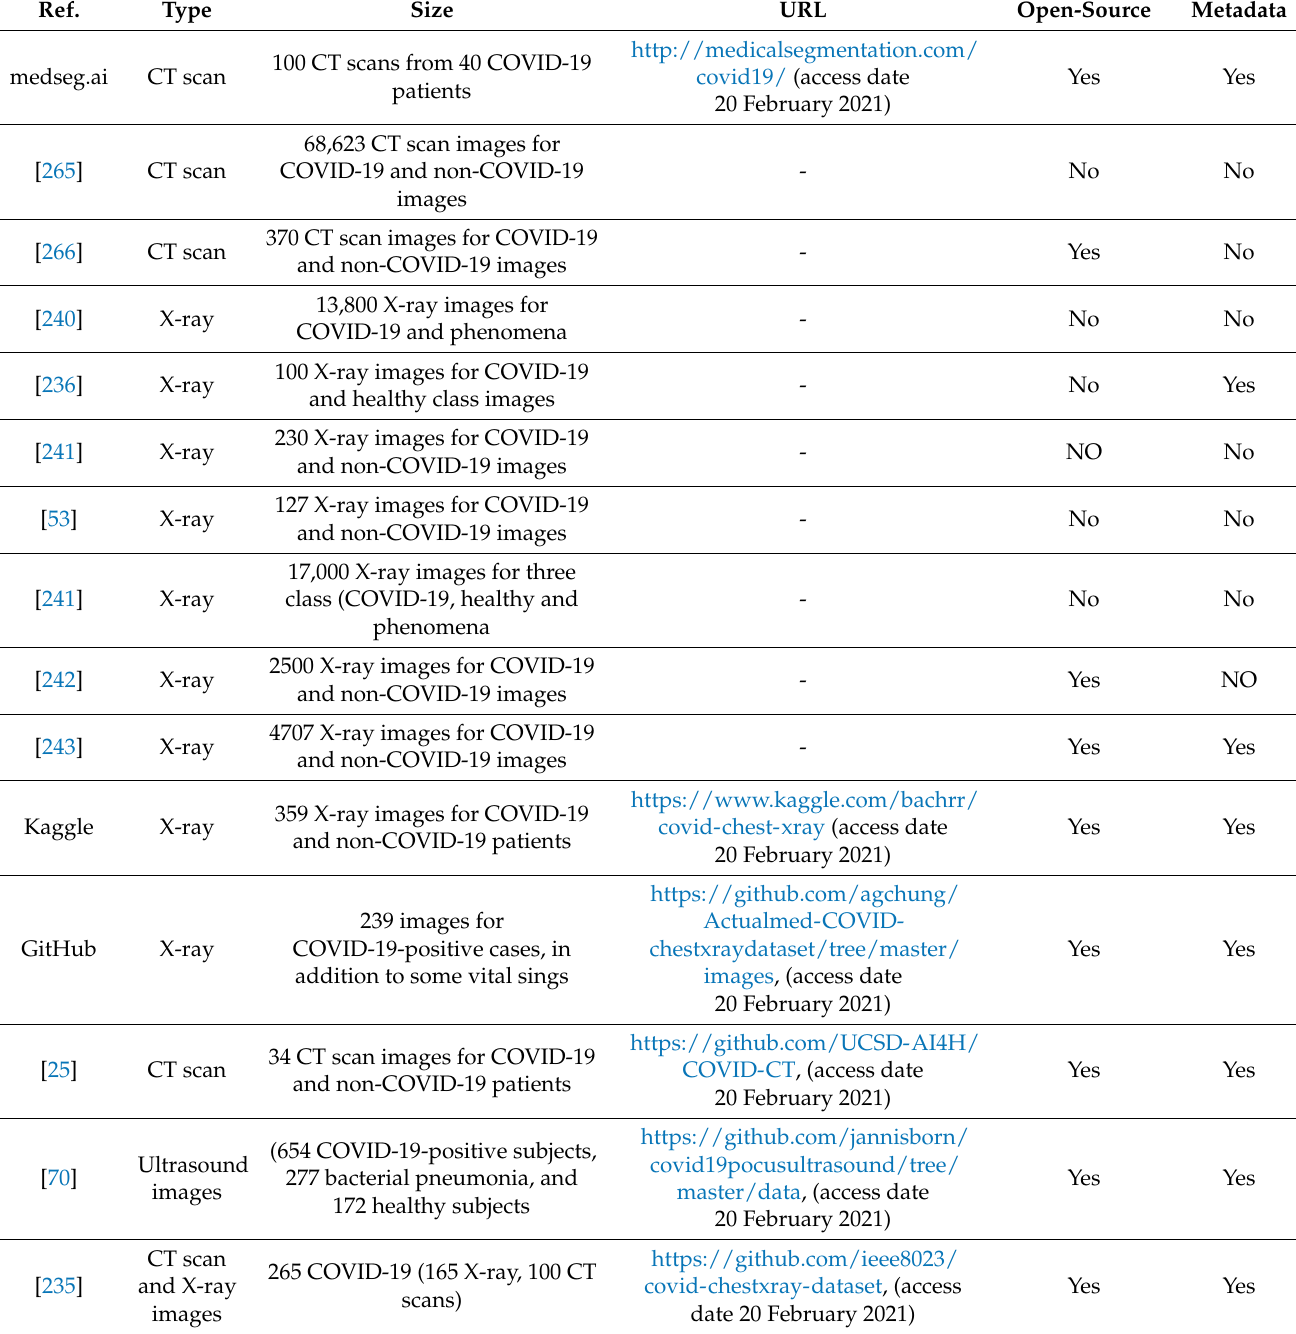
Table 8. Comparison between the COVID-19 medical images